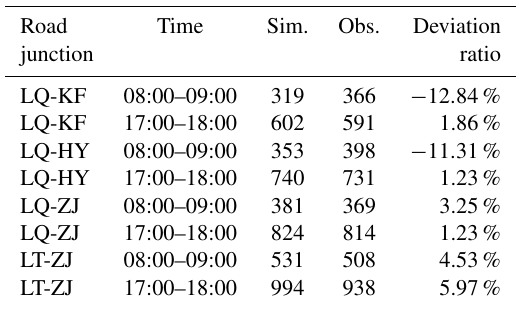
Table 6. Traffic flow and population simulation results during peak hours on weekdays. Road Time Sim.